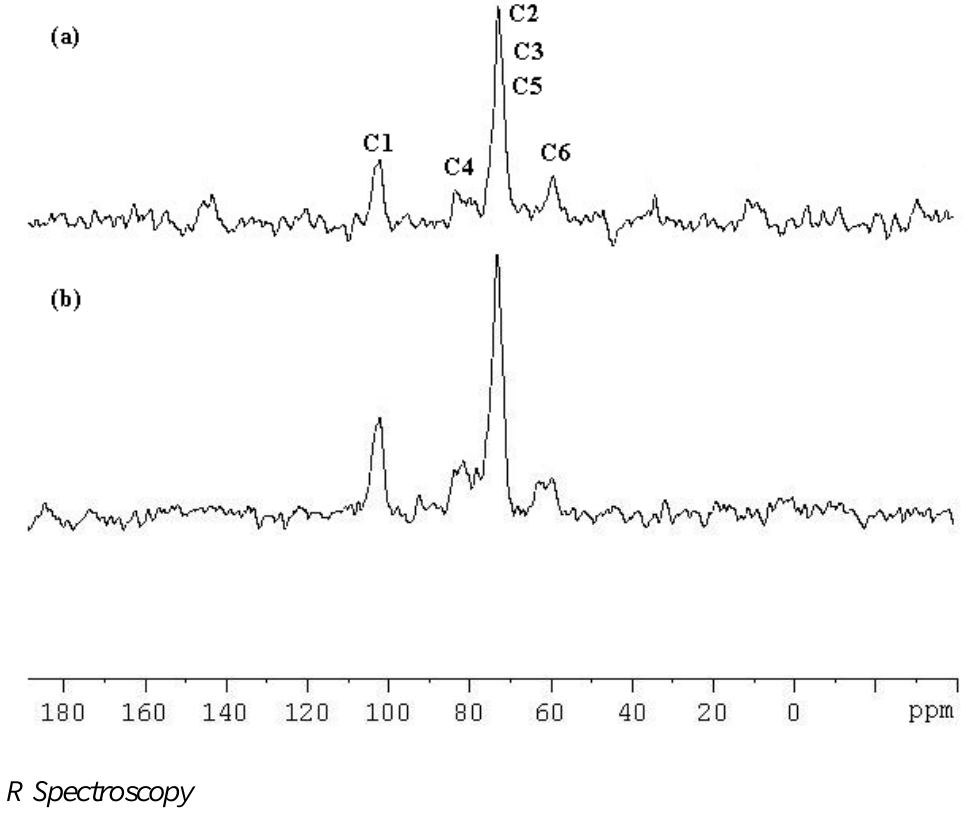
Figure 5. 13 C CP/MAS NMR spectra of ( a ) β-CD-TetraPhimBr and ( b )